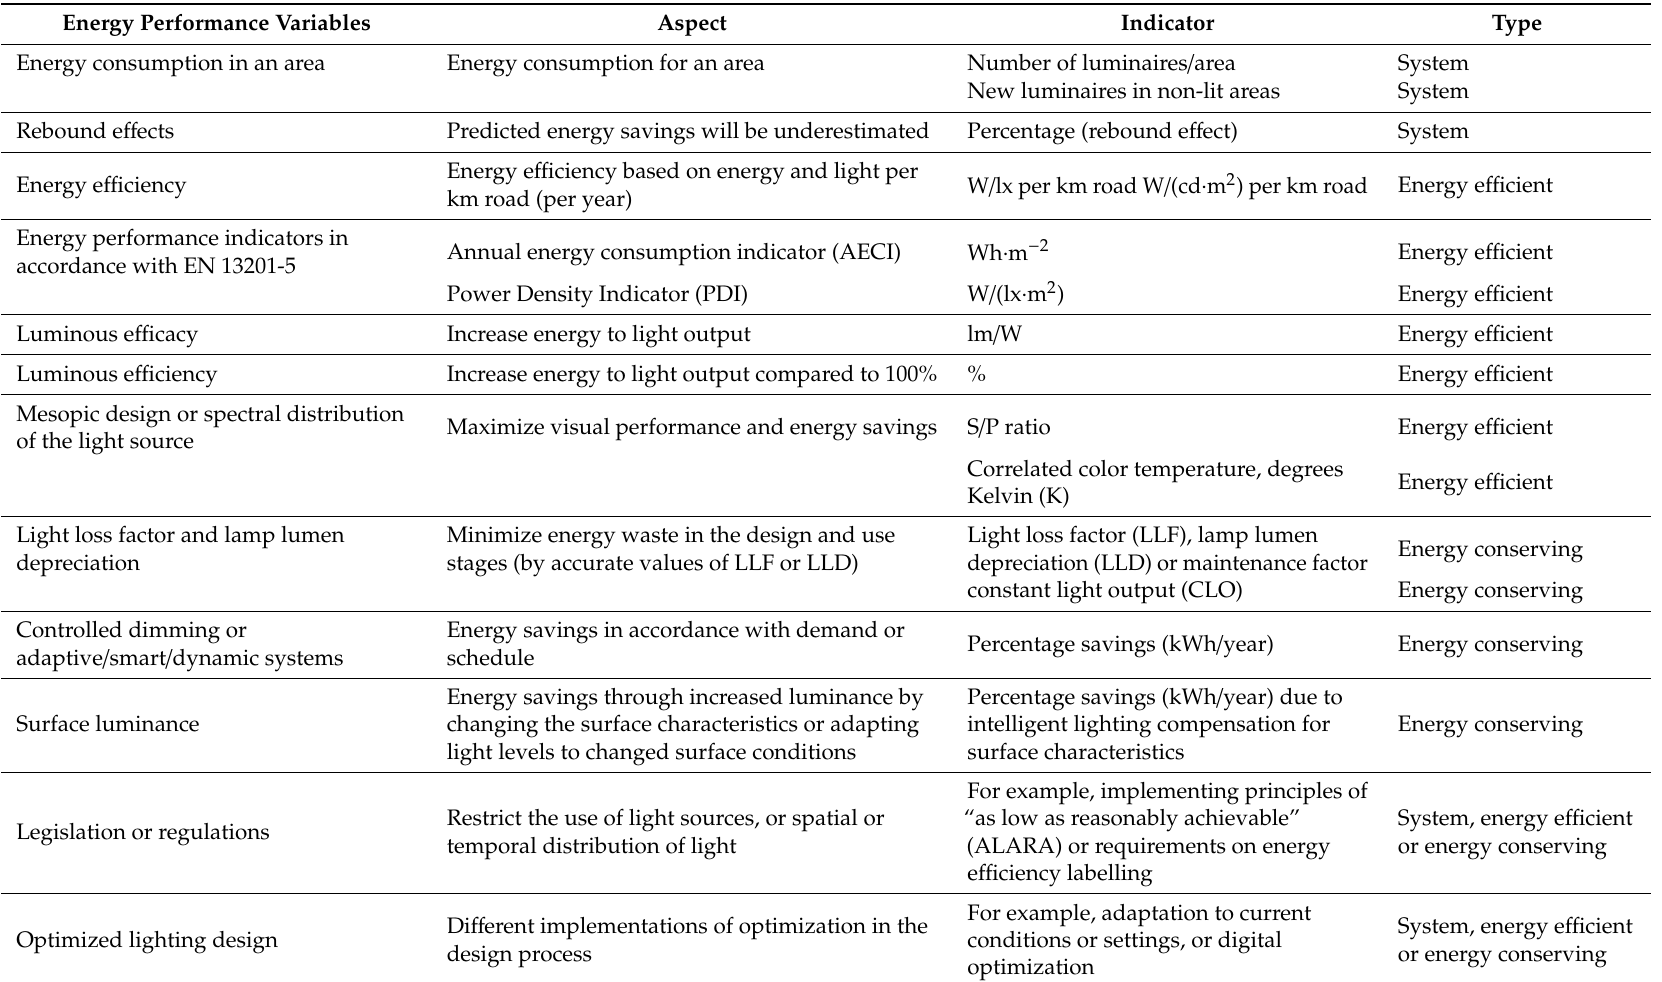
Table 2. Energy performance variables, aspects, indicators, and type. Energy performance is classified as system-wide (system), energy efficient, or energy conserving